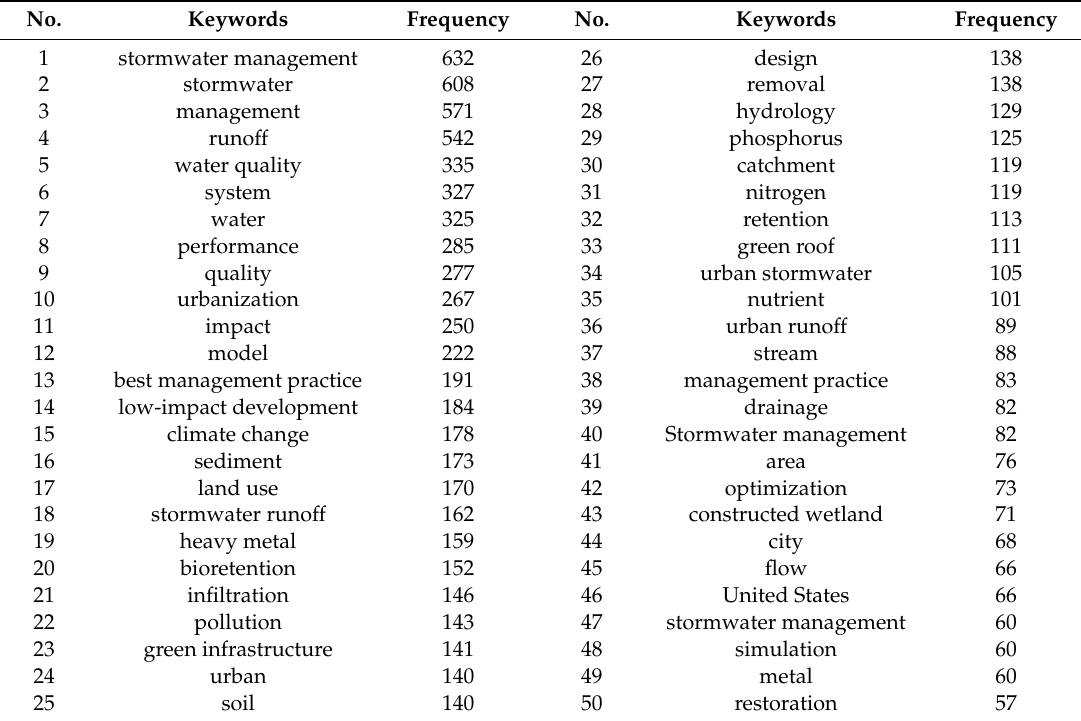
Table 4. Top 50 keywords with their frequencies in stormwater